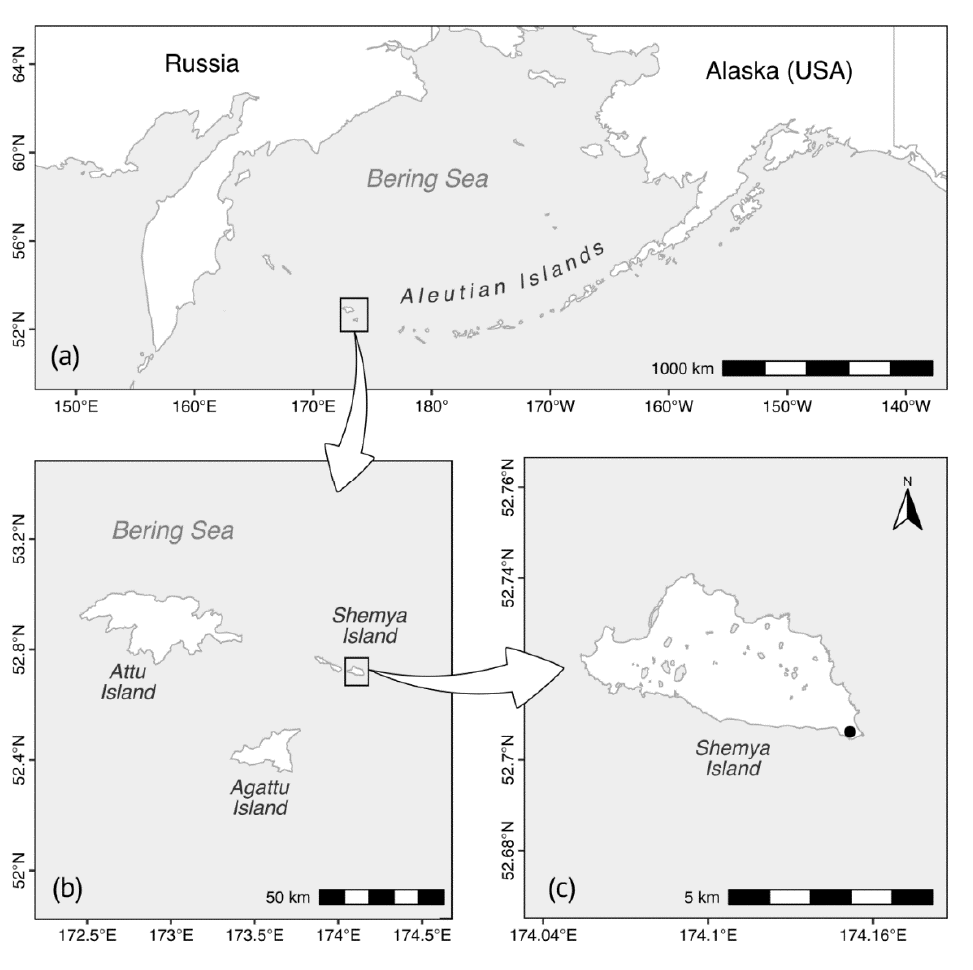
Figure 1. The general view of the Aleutian Islands ( a ), group of the Near Islands ( b ), Shemya Island ( c ) with McDonald point peat location (marked by black dot).